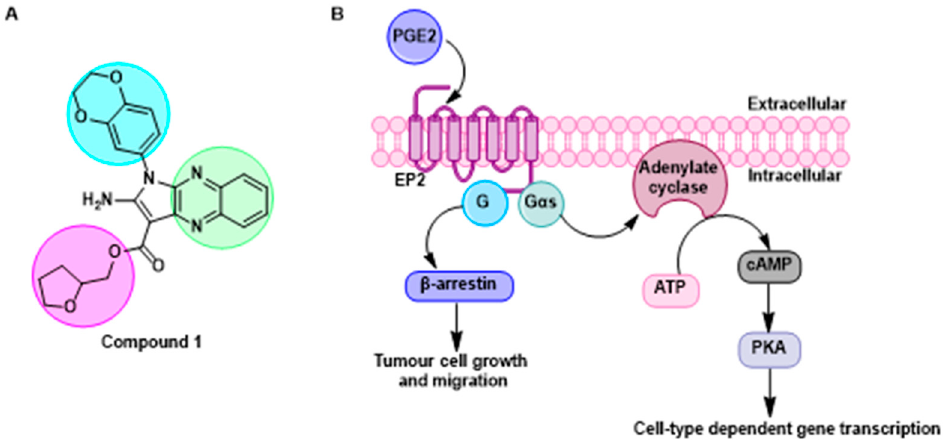
Figure 13. ( A ) Structure of Compound 1 highlighting three regions of interest for structural modification in blue, pink and green. ( B ) PGE2 binds and activates EPS, G α s -mediated induction of adenylate cyclase to increase cytoplasmic cAMP levels. Downstream events are then mediated through protein kinase A. EP2 activation also induces β -arrestin which is known to promote tumor cell growth and migration.